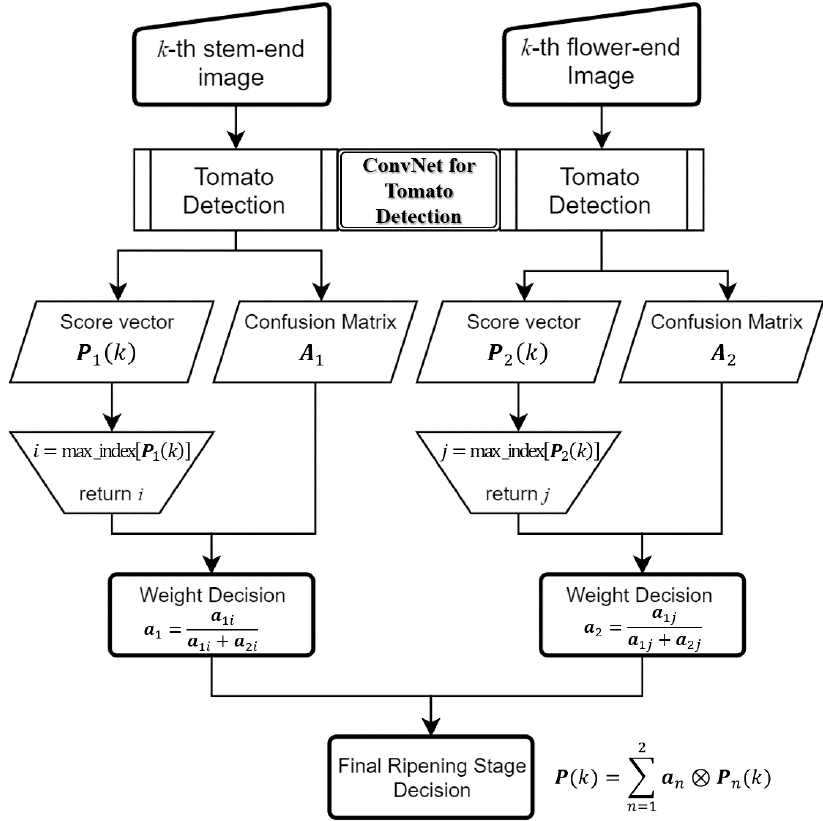
Figure 5. Flowchart of the proposed stochastic decision fusion algorithm.